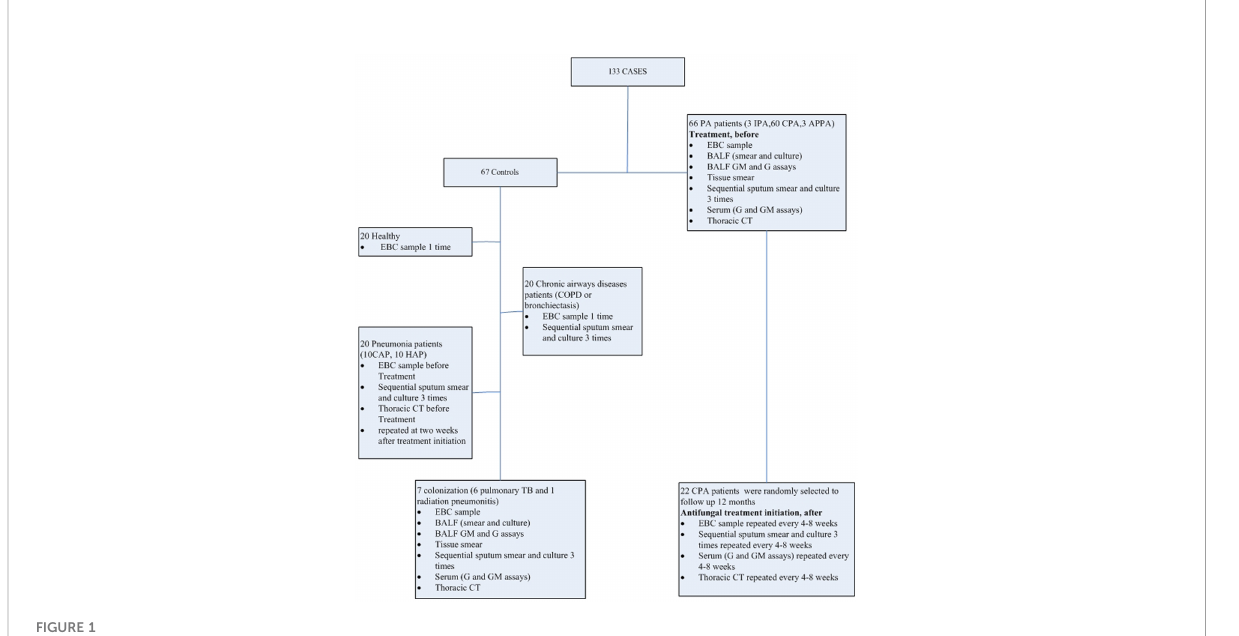
FIGURE 1 Flow chart of study